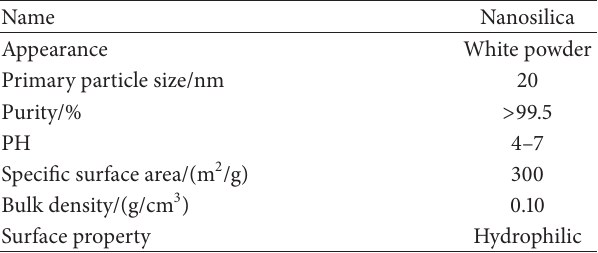
Figure 7: The influence of NS content on the CCW of cement paste around GHB. Table 3: Physical properties of